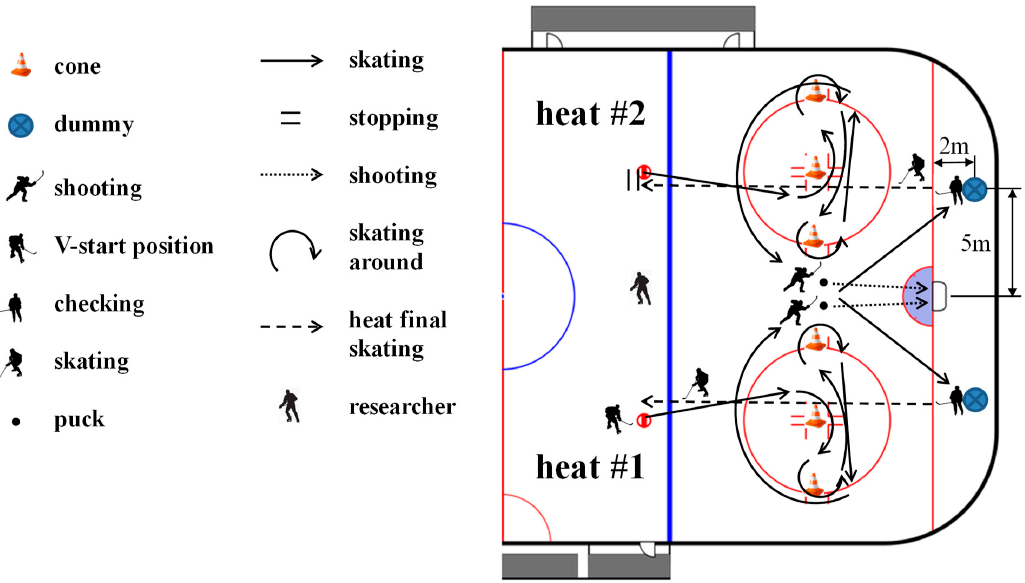
Figure 1. Schematic diagram of the specific overall skating performance test (SOSPT). In the SOSPT, subjects performed two heats including all main skating movements and hockey specific movements (shooting and checking) on a regular-size ice hockey field, as shown in Figure 1. In heat #1, the subjects began from a standard hockey V-start from the neutral zone faceoff spot (the rear foot was placed on the faceoff spot) and skated around a cone at the end zone faceoff spot to and around a cone placed on the lower hash mark of the goal opposite side in the end zone circle. Subsequently, the subjects skated to and around the cone placed on the lower hash mark of the goal facing side in the end zone circle and back to a cone on the lower hash mark of the goal opposite side in the end zone circle. After skating around the cone, the subjects skated around the end zone circle and shot a puck at the goal. The puck was placed one meter beside the high hash mark of the facing side in the end zone circle. The shot on goal was performed at full skating speed and the subjects skated through the goal line to the board on the left side of the goal, stopped, and simulated a body check on a dummy-placed five meters beside the midpoint of the goal and two meters below the goal line, as shown in Figure 1. Heat #1 ended with a final skating to neutral zone faceoff spot, stopping at the spot, and directly starting heat #2. The procedure in heat #2 was identical to heat #1; however, the other side of the field was used to reduce fading of the ice and to perform all movements in the opposite direction to avoid one-sidedness. The direction of skating was fixed by the test protocol as described in Figure 1 and was identical for all participants. Time was measured with a standard hand-held stopwatch (Hanhart Stratos 2, Hanhart GmbH, Gütenbach, Germany) from the subject’s first movement (take-off of the rear foot) until crossing (first touch of the front foot) the neutral zone faceoff spot (start and finish). The researcher was placed between the two faceoff spots to enable a good view of the subjects (Figure 1) for determining time (start/stop) and controlling whether the subjects touched the faceoff spot between heat #1 and heat #2. Each subject completed one valid trial. A trial was invalid if the subjects slipped or touched a cone. If a second trial was necessary, the recovery time between the two trials was 3 min. No subject needed more than two trials of the SOSPT. The SOSPT has been validated in a previous study [19] with high reliability (ICC (2,1) = 0.92; CV = 2.44%) and validity with a strong and significant correlation between an expert rating and the SOSPT time.